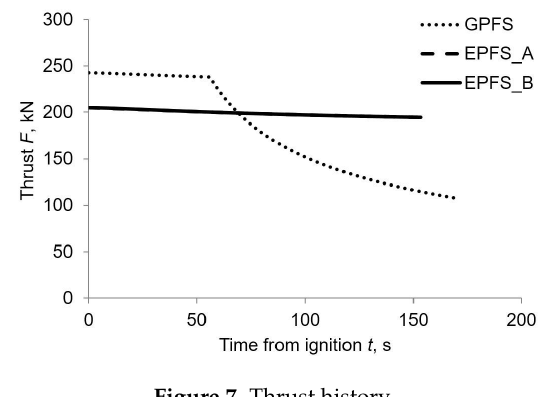
Figure 7. Thrust history.